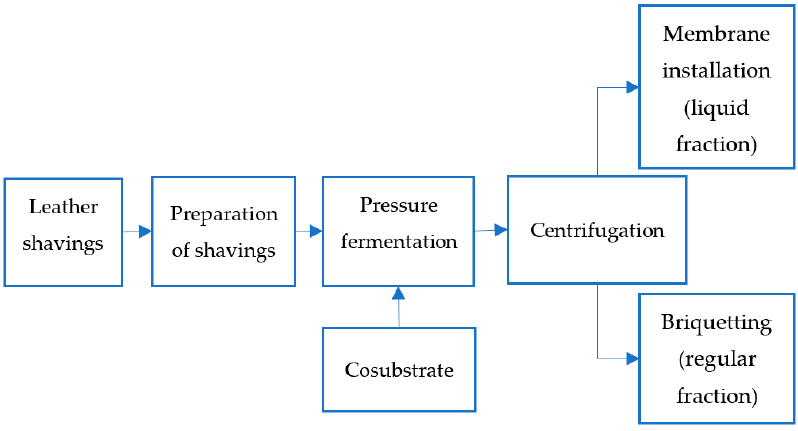
Figure 2. Scheme of the system for managing the post-production residue of the leather tanning process.